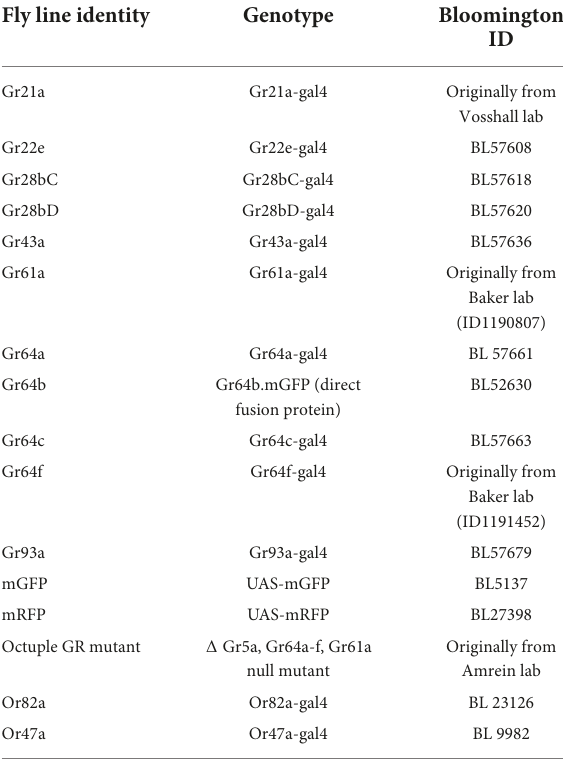
TABLE 1 A list of all fly lines used during the experiments. TABLE 2 List of chemicals used for identifying odor-tuning properties of neurons innervating ab5 sensillum